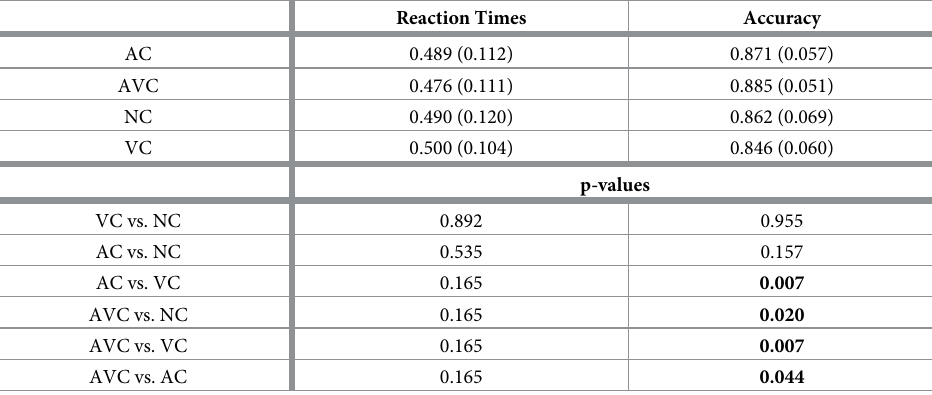
Table 2. Top half: RTs (in seconds) and accuracy (proportions of correct responses), with standard deviations, in the different pre-stimulus conditions, regardless of SOA. Bottom half: p-values of pairwise comparisons (one-tail t-tests, Benjamini-Hochberg adjusted), with statistically significant values in bold ( α = .05).